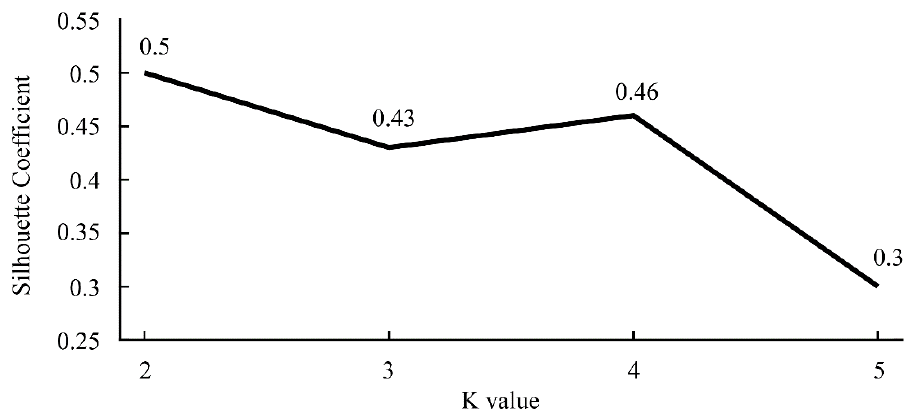
Figure 3. Distribution of silhouette coefficient vs. clustering number of precipitation division in Poyang Lake basin based on K-Means algorithm.